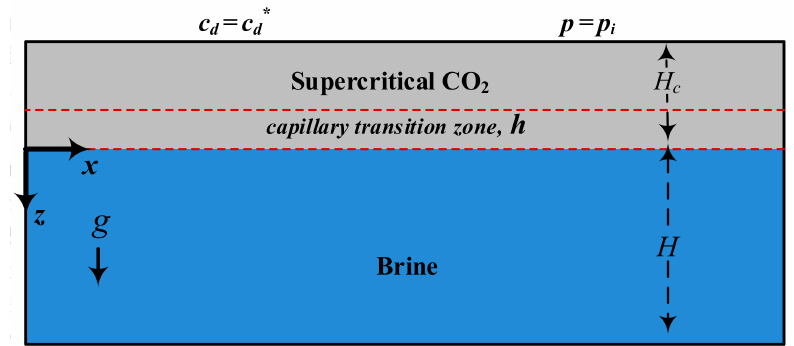
Figure 1. Schematic of the domain and initial state of the two-phase system. The origin of the space coordinate is at the interface between H c and H